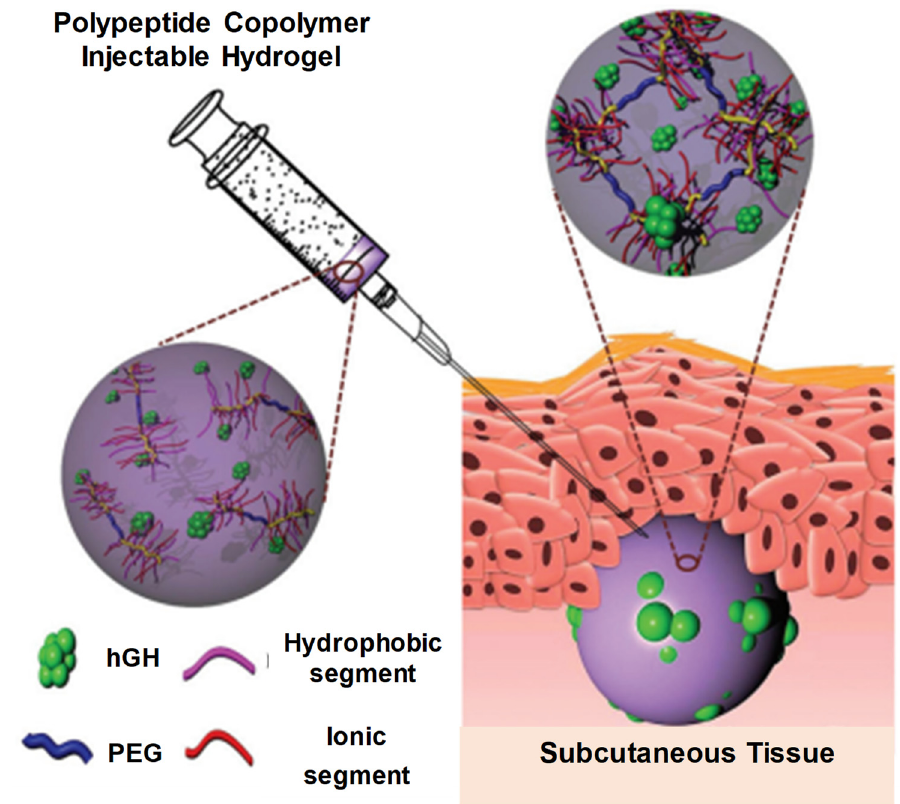
Figure 19. Schematic diagram showing injectable and hGH-loaded PNLG-co-PBLG-b-PEG-b-PBLG-co-PNLG hydrogels (a polypeptide copolymer) and their application for protein delivery. The polypeptide copolymers exist as a sol in the syringe and are transformed to a gel after subcutaneous administration. Reprinted with permission from ref. [7]. Copyright © 2021 Journal of Control Release , Elsevier.